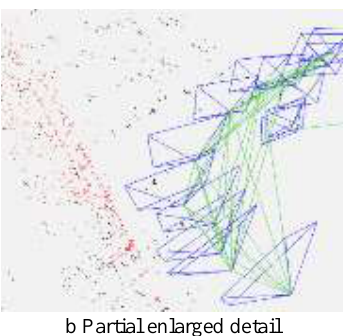
Figure 2.Real-time positioning result display As shown in figure 3, the process of tracing displayed points is expressed by a rectangular pyramid instead of only a point to stand for the location of the present frame. The result of positioning is expressed by the rectangular pyramid. The normal vector of the bottom plane of the rectangular pyramid is used to express the rotation magnitude of the present frame and the global coordinate system tri-axial rotation magnitude. If the green solid line of the data between every two frames is jointed, it means there are some certain identical feature points of data in the adjacent frames, hence, the loop closure detection is